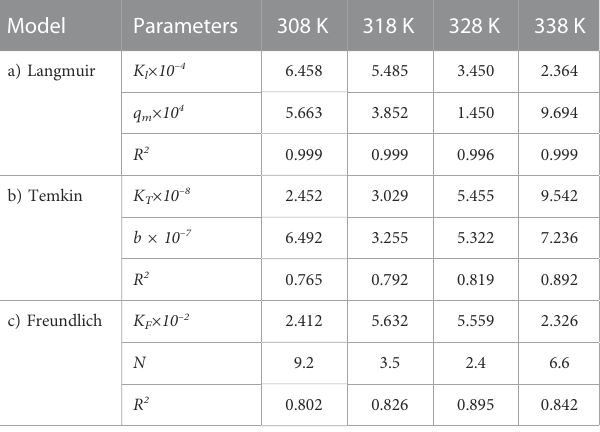
TABLE 6 Parameters of a) Langmuir, b) Temkin, and c) Freundlich isotherm models at different temperatures using Oil sludge 3 as carbon active at pH = 5 and adsorbent concentration of 100 mg/L.